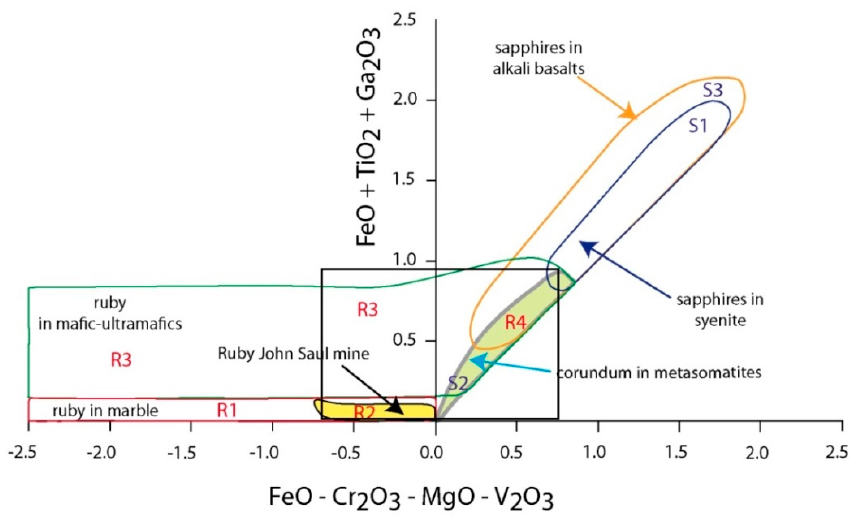
Figure 17. FeO-Cr 2 O 3 -MgO-V 2 O 3 versus FeO + TiO 2 + Ga 2 O 3 diagram based on a database of 2000 electron microprobe analysis (EMPA) analyses (in wt % oxides) showing the main chemical fields defined for different types of corundum deposits worldwide [72]. Different geochemical domains are defined (see text).